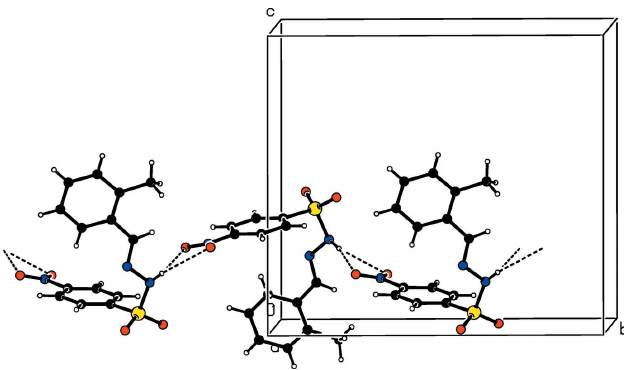
Figure 6 A partial view along the a axis of the crystal packing of compound (II), with hydrogen bonds shown as dashed